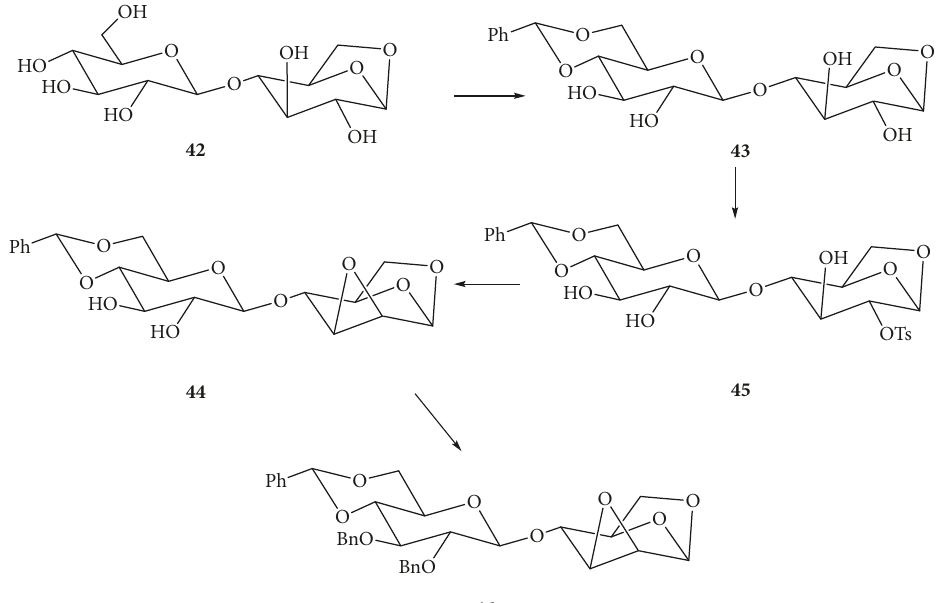
Scheme 14: Synthesis of the DC disaccharide fragment from